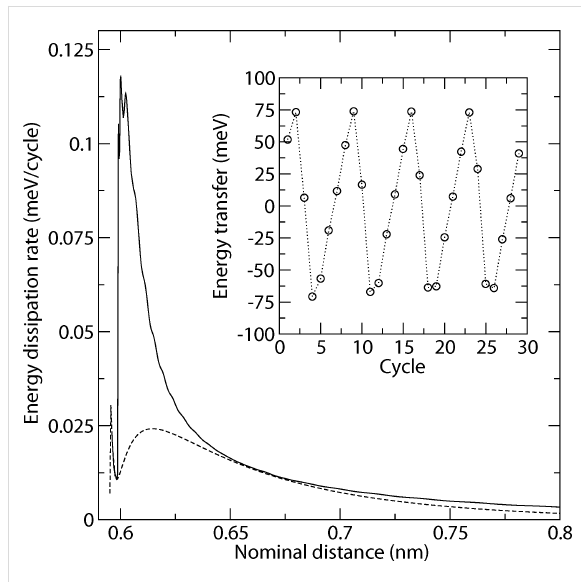
Figure 4: Distance dependency of dissipation rate for one cycle (dashed line) and averaged over 30 cycles (solid line). Inset shows the energy transfer per cycle for the nominal distance d = 0.605